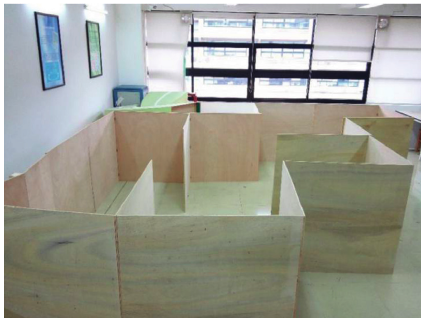
Figure 9: Emulated rescue environment.